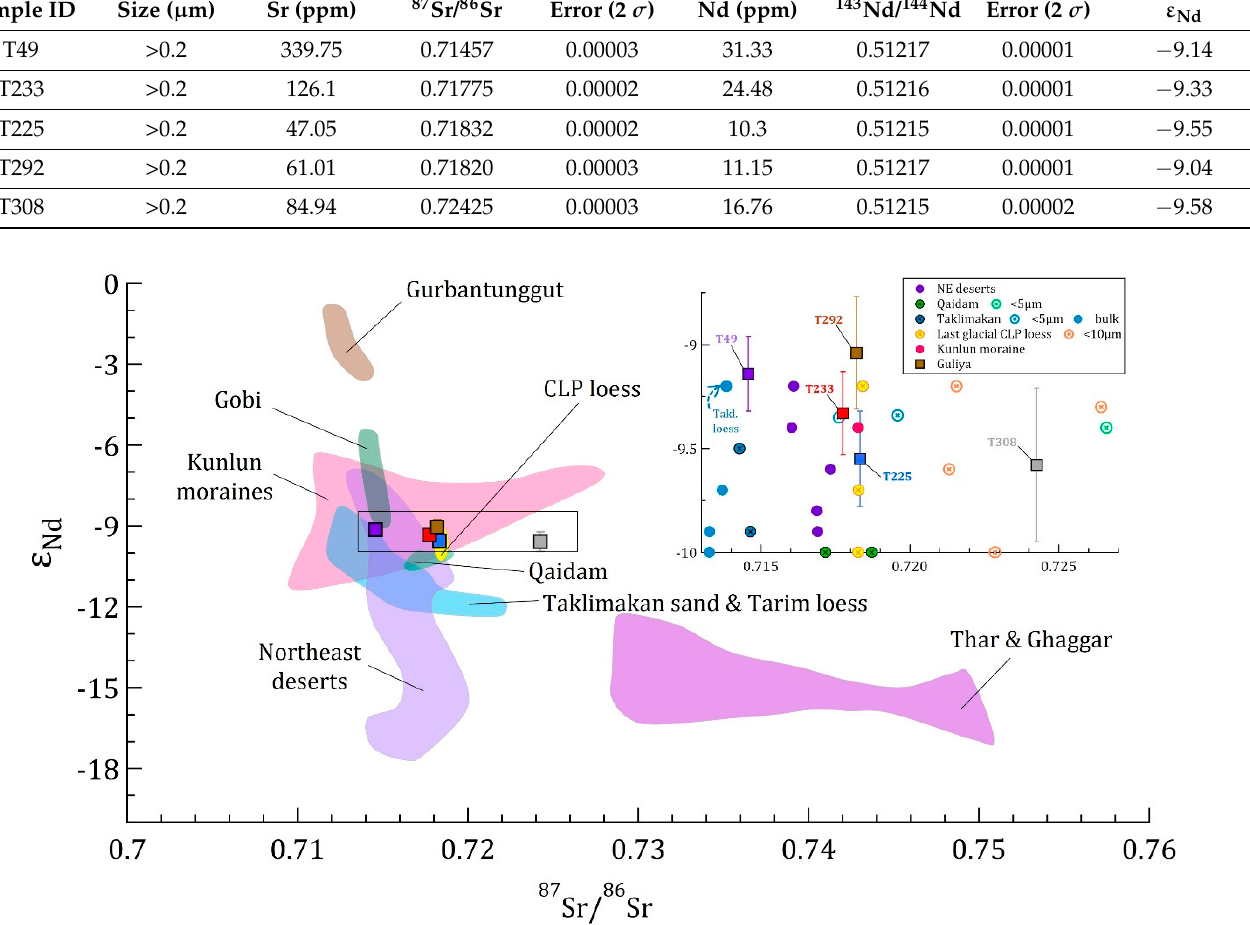
Table 2. Sr-Nd isotopic composition of dust filter samples.